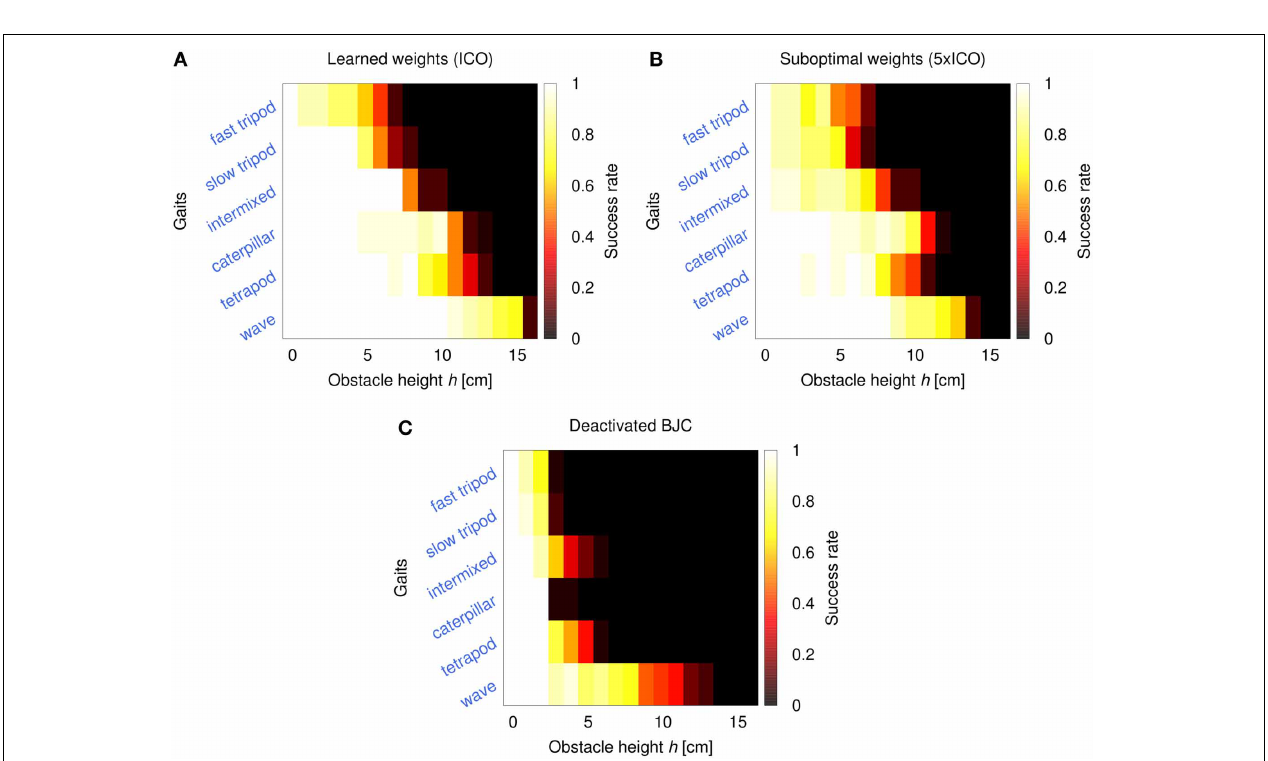
FIGURE 12 | Performance heatmaps of AMOS II obstacle negotiation with respect to obstacle height h and gait parameter c using three different control configurations. (A) Activated BJC with learned weights (ICO), (B) activated BJC with suboptimal